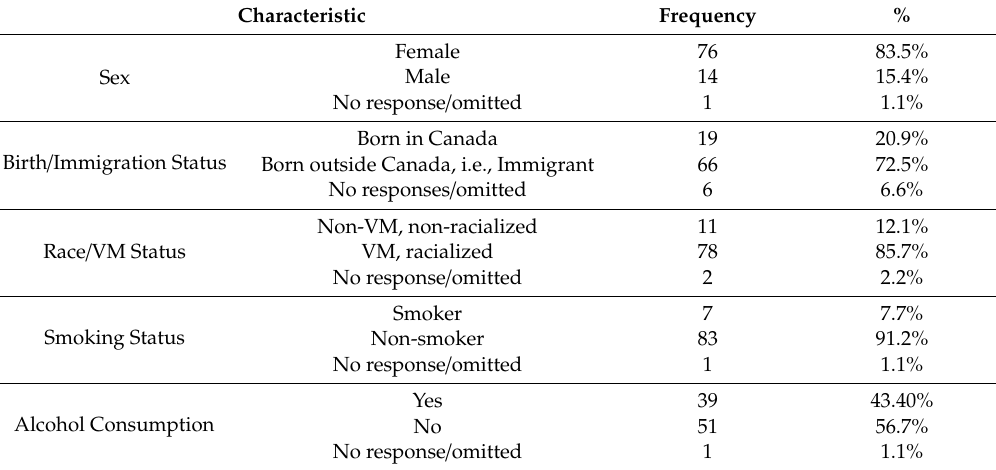
Table 2. Descriptive statistics of the survey sample ( n =